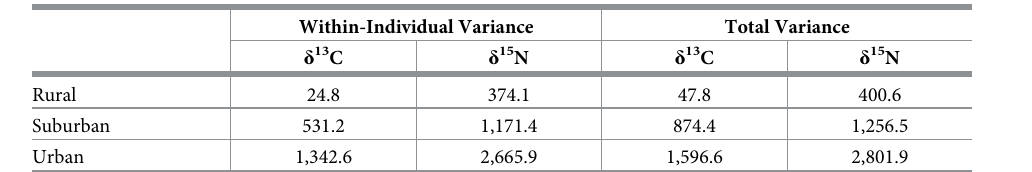
Table 5. Variance components of coyote whisker